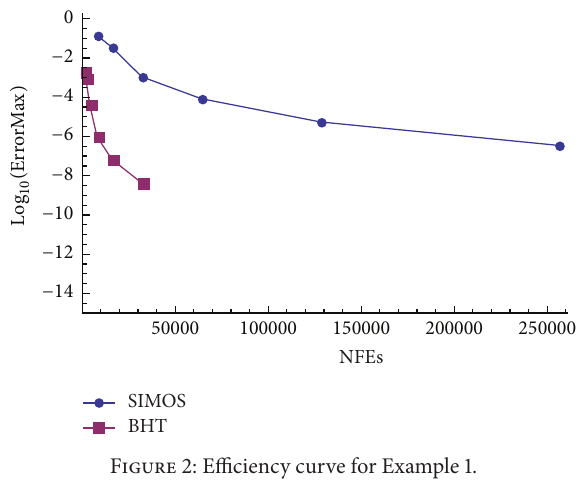
Figure 3: Efficiency curves for Example 2. Table 2: Results, with 𝜔 = 1.01 , for Example